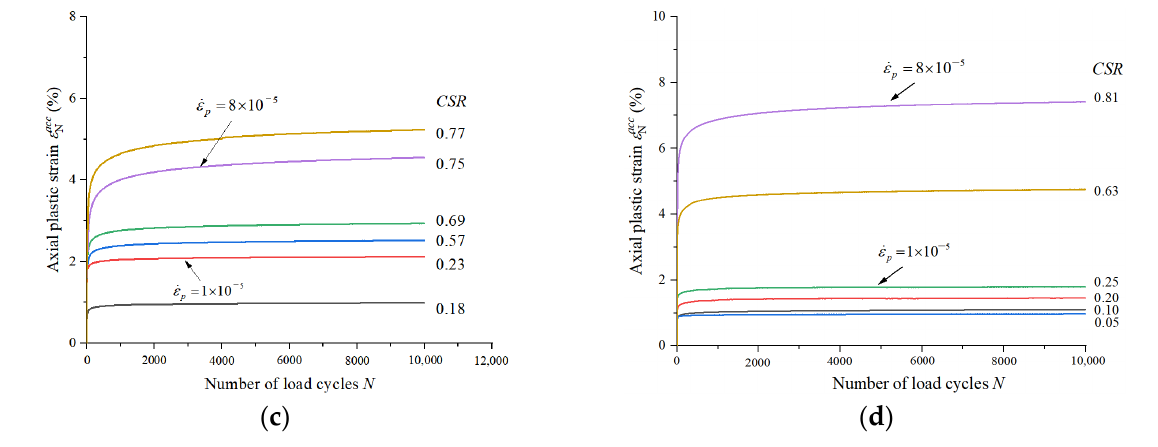
Figure 15. Development of plastic strain of calcareous sand samples: ( a ) Effective confining pressure σ 3 = 40 kPa; ( b ) Effective confining pressure σ 3 = 60 kPa; ( c ) Effective confining pressure σ 3 = 80 kPa; ( d ) Effective confining pressure σ 3 = 100 kPa.